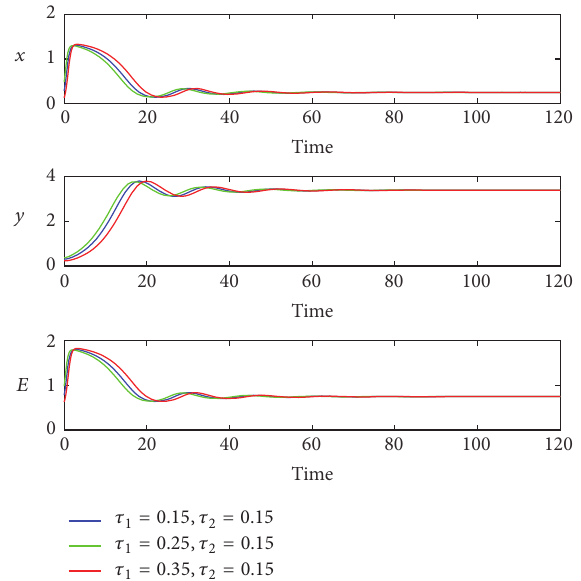
Figure 1: Stable dynamical variation of optimal prey, predator biomass and optimal harvest control with the increasing time under = 0.15, 0.25, 0.35 and 𝜏 = 0.15 , respectively. 𝜏 1 2